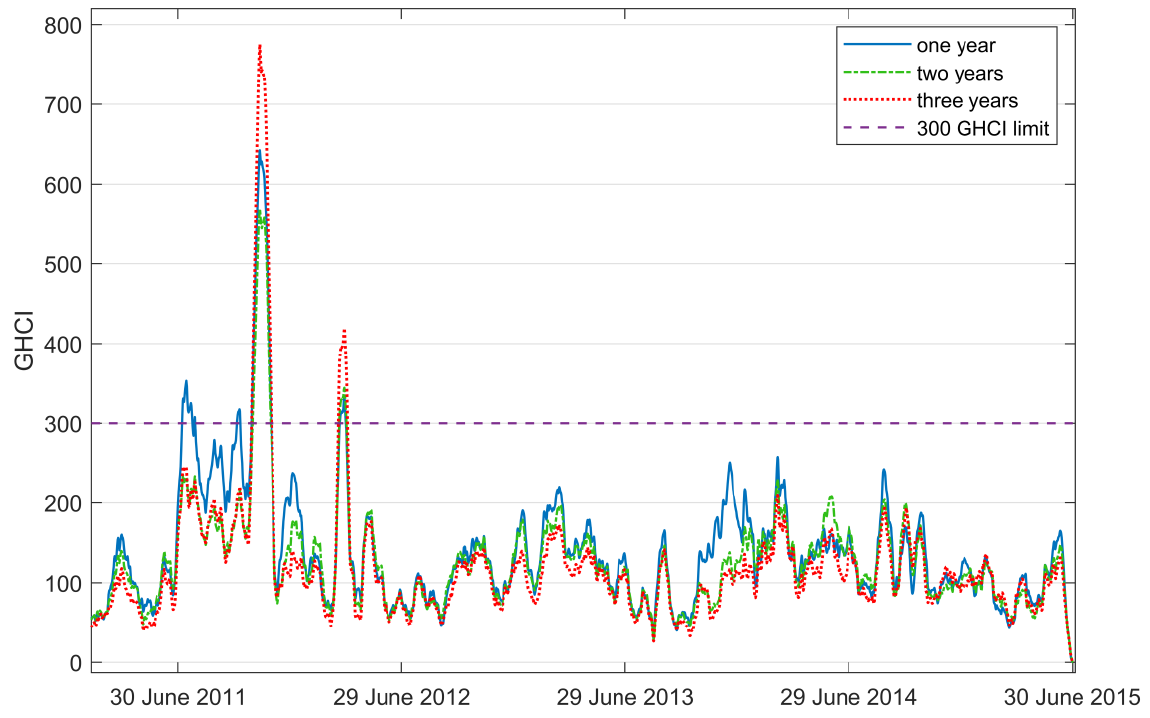
Figure 14. General Health and Conditions Indicator aggregating alarms of all agents.